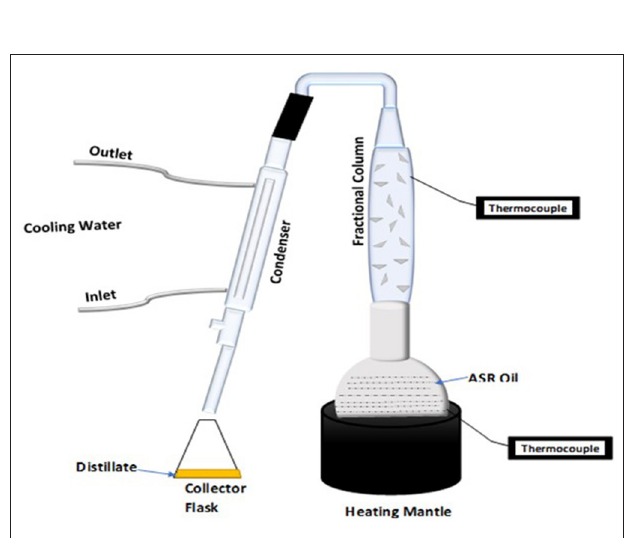
FIGURE 2 | Schematic diagram of fractional column distillation for ASR pyrolysis oil.